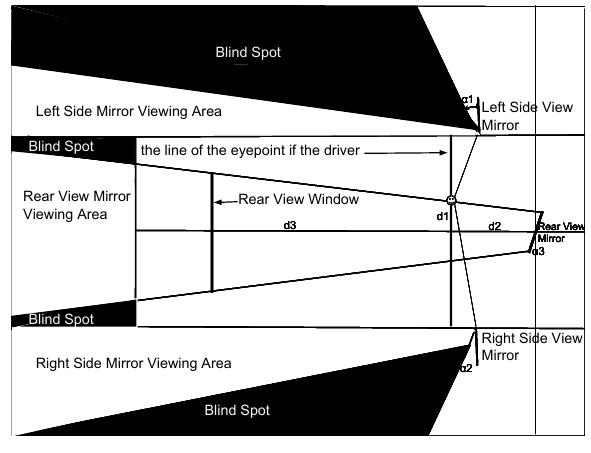
Figure 7. The line of view of the driver with the left mirror improperly